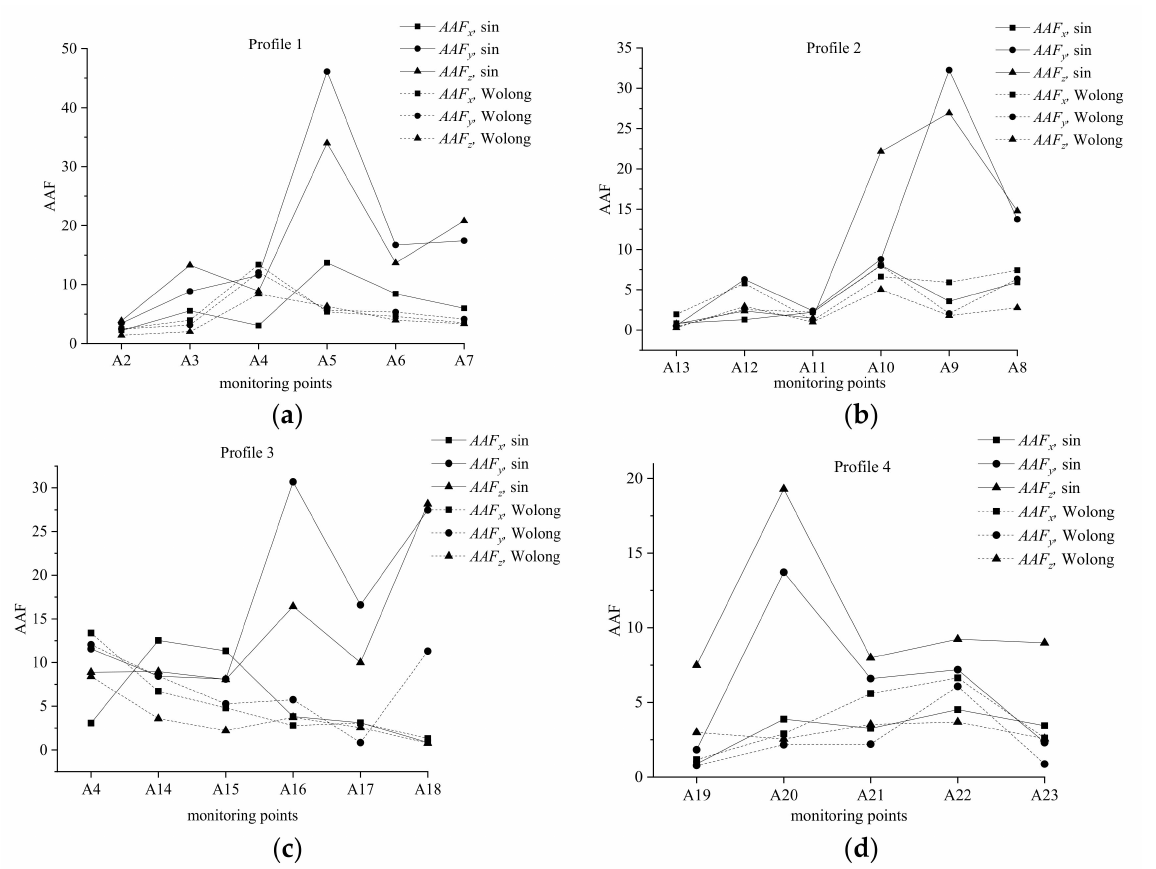
Figure 7. Variation of the acceleration amplification factors at different acceleration monitoring points due to the action of natural seismic and sinusoidal waves for points along profiles: ( a ) 1, ( b ) 2, ( c ) 3, and ( d )